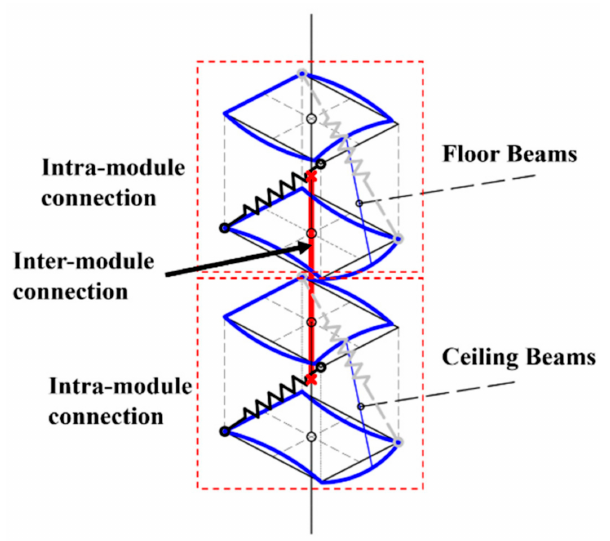
Figure 30. Three-dimensional component model for the novel modular